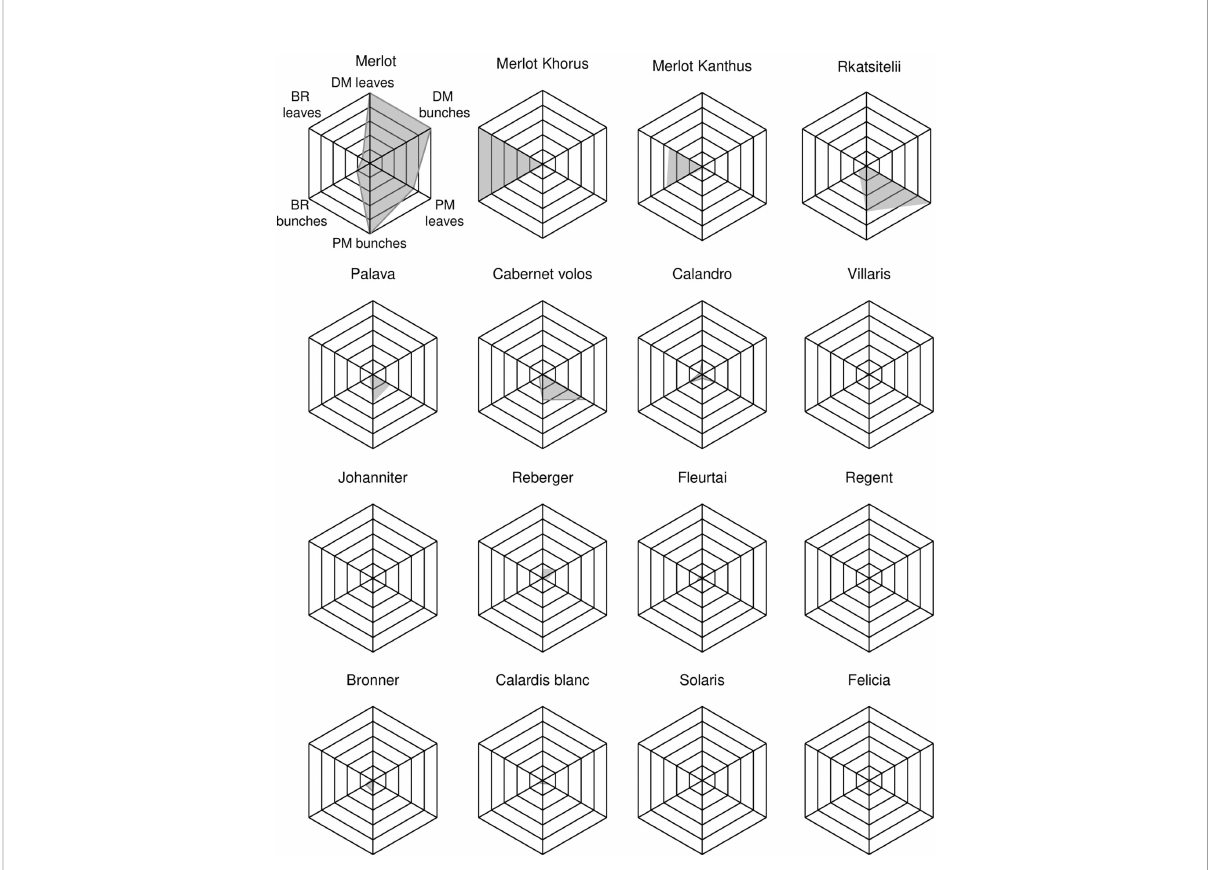
FIGURE 4 Spider graphs representing the resistance pattern of grapevine varieties with regard to downy mildew (DM), powdery mildew (PM), and black rot (BR) on leaves and bunches. In each spider graph, the black net ranges from 0 to 1 for each disease and organ, where 1 is the highest disease value found in the experiment, expressed as AUDPC (Area Under the Disese Progress Curve), which was 6.542 ( ‘ Merlot ’ ), 8.461 ( ‘ Rkatsitelii ’ ), 4.492 ( ‘ Merlot Khorus ’ ) on leaves for DM, PM, and BR, respectively, and 5.610 ( ‘ Merlot ’ ), 5.720 ( ‘ Merlot ’ ), and 17.583 ( ‘ Merlot Khorus ’ ) on bunches for DM, PM, and BR, respectively. The grey area is originated by the 4-year averages (also rescaled from 0 to 1) of AUDPC values. For each disease and organ, the rescaled 4-year average of AUDPC was obtained by dividing the value by the highest average